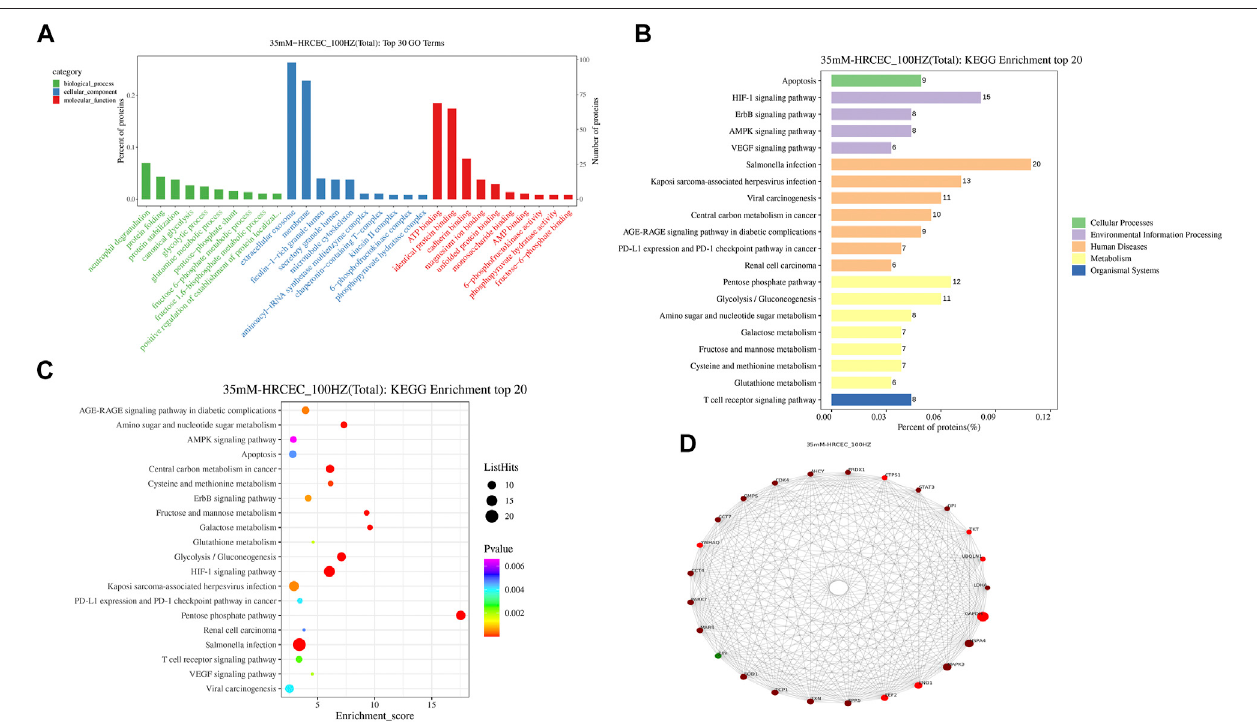
FIGURE 7 | GO/KEGG/PPI analyses of differentially expression proteins. (A) GO enrichment of differentially expression proteins. (B) Differentially expression proteins distribution at KEGG Level 2. (C) Bubble diagram of TOP 20 KEGG enrichment. (D) PPI network diagram of differentially expression proteins. HZ: HZQMY.